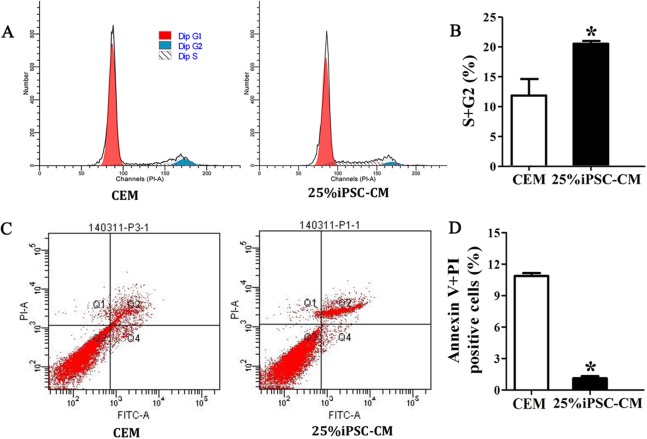
iPSC-CM treatment promoted antiapoptotic activity in cultured B-CECs.(A) Cell cycle analysis of B-CECs between the 25% iPSC-CM group and CEM group. (B) Quantification of the cell cycle assays showed the percentage of cells entering the S and G2 phases were higher in 25% iPSC-CM than in CEM. (C) Annexin V and PI assay of the B-CECs in the 25% iPSC-CM group and CEM group. The Q1 area represents cell necrosis; Q2 represents late-apoptotic cells; Q3 represents viable cells; and Q4 represents early apoptotic cells. (D) Quantification of the Annexin V and PI assays. The percentage of apoptotic cells was calculated from Q2 and Q4. The number of apoptotic cells decreased in the 25% iPSC-CM group, which showed a statistically significant difference (*P < 0.05 was considered statistically significant; versus CEM group, n = 3).